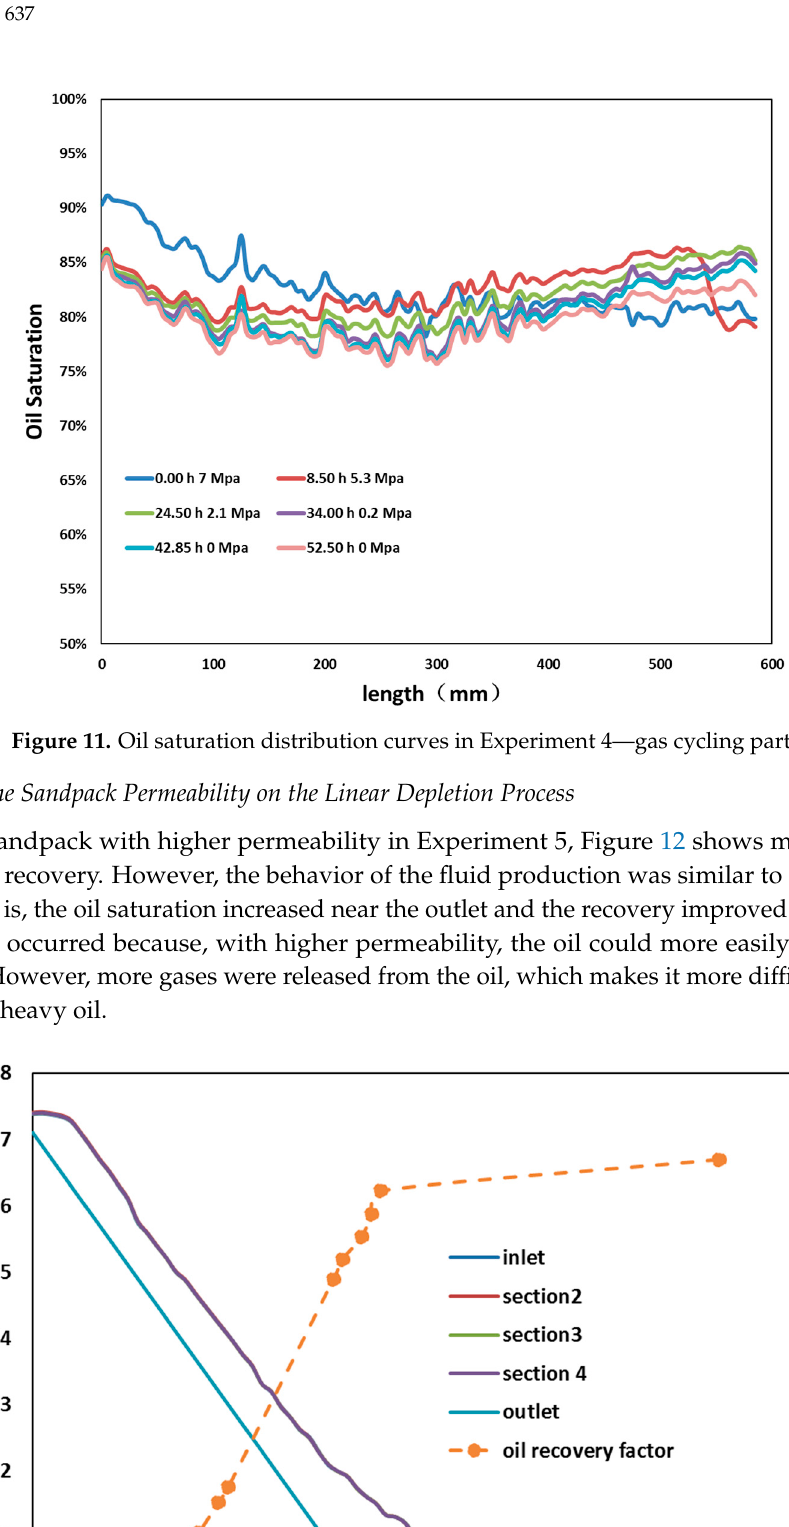
Figure 10. Relationship between pressure changes and oil recovery in Experiment 4—gas cycling part.